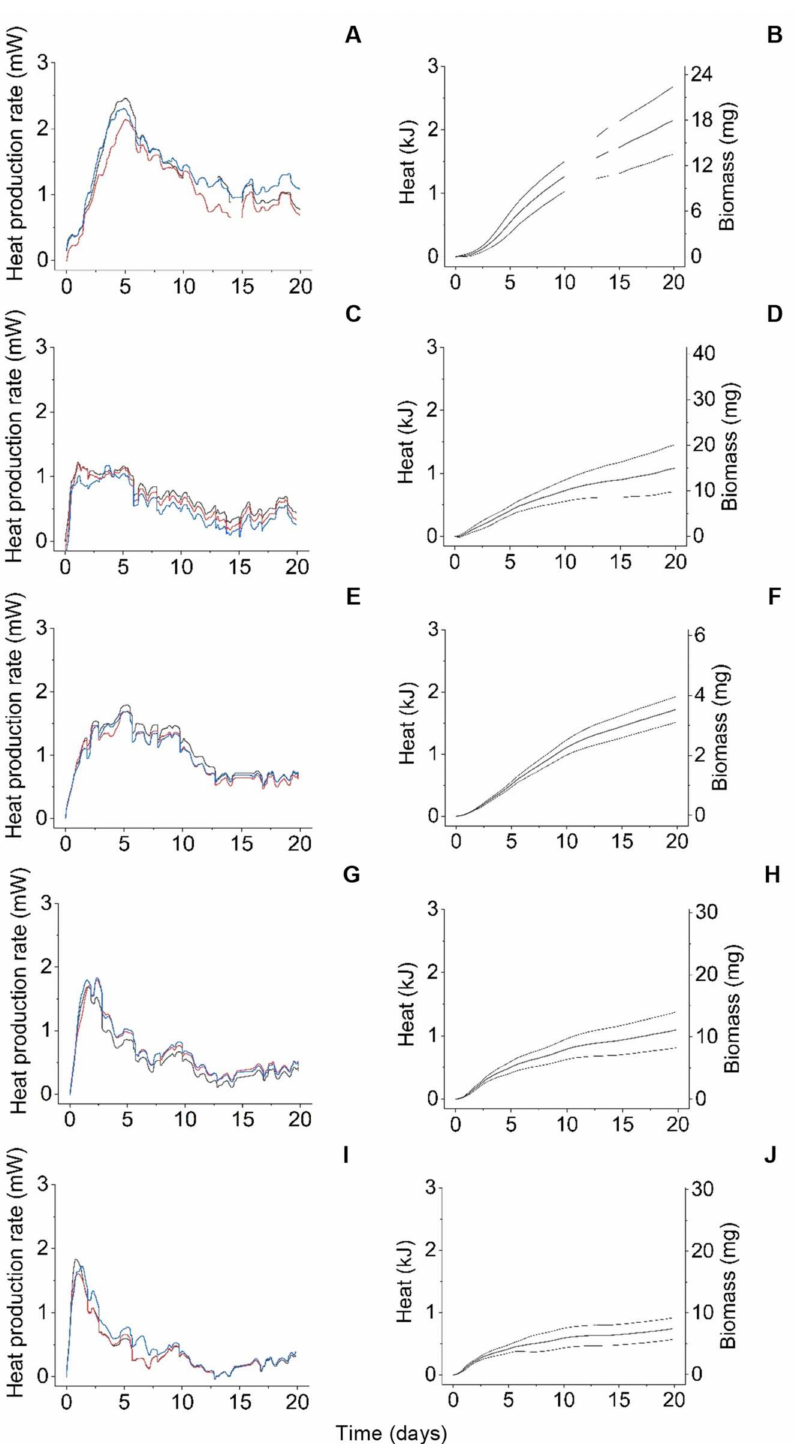
Figure 3. Metabolic heat production rate versus time ( A , C , E , G , I ), and heat (integral of the heat production rate) and fungal biomass increase (i.e., biomass yield) versus time ( B , D , F , H , J ) during the growths of S. commune ( A , B ), G. butleri ( C , D ), G. trabeum ( E , F ), T. reesei ( G , H ), and P. chrysogenum ( I , J ) on wheat straw. Triplicate traces shown in black, blue and red colour in A,C,E,G,I, respectively, always stem from triplicate fungal cultures. The bold lines in B,D,F,H,J are the means of the triplicate fungal cultures, and the thin dotted lines denote the corresponding upper and lower 95% confidence limits, respectively (not calculated for the occasional time periods of the suspended recording of the heat production rate due to technical reasons, as can be seen in Figure 3A; this led to gaps in the traces shown in Figure